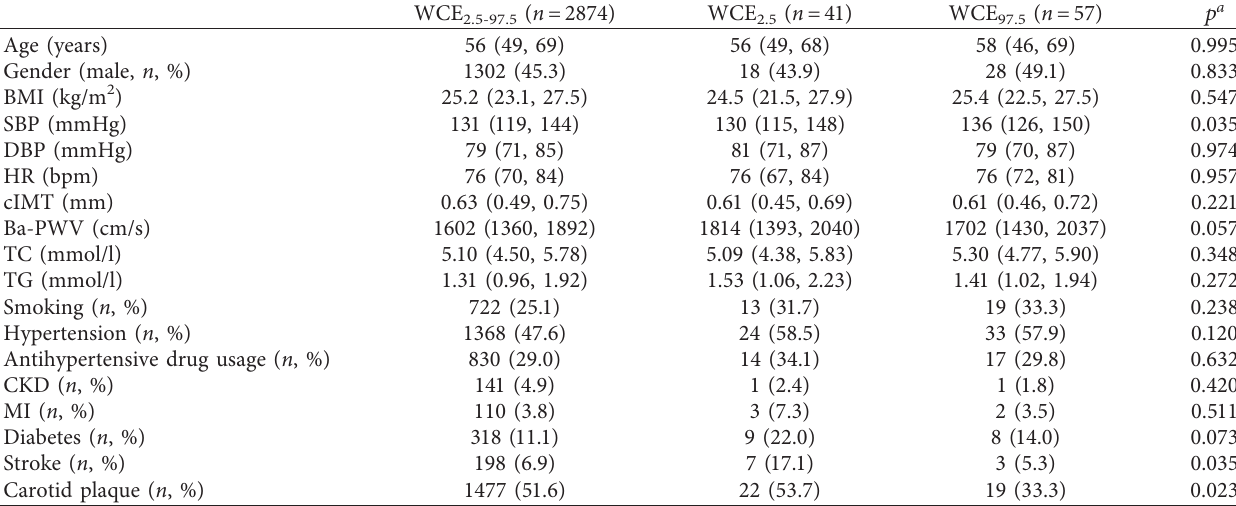
Table 2: Comparison of the general characteristics of the three groups of WCE.